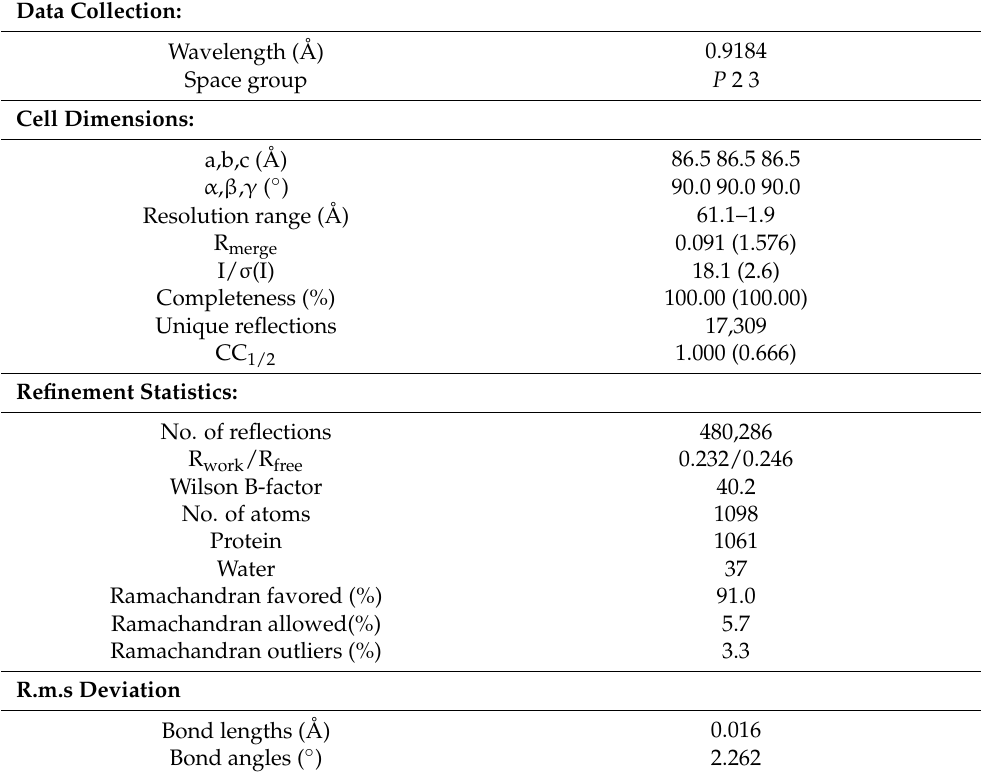
Table 1. Data collection and refinement